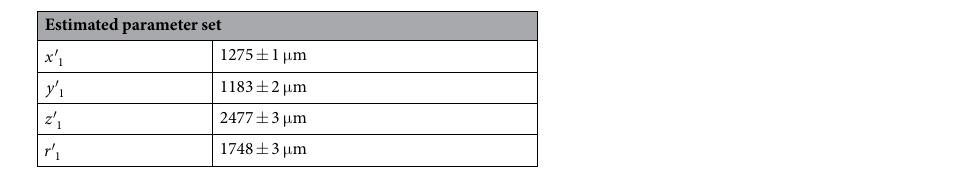
Table 2. Representative average and standard deviation of the optimal parameters. (Average ± standard deviation, n =